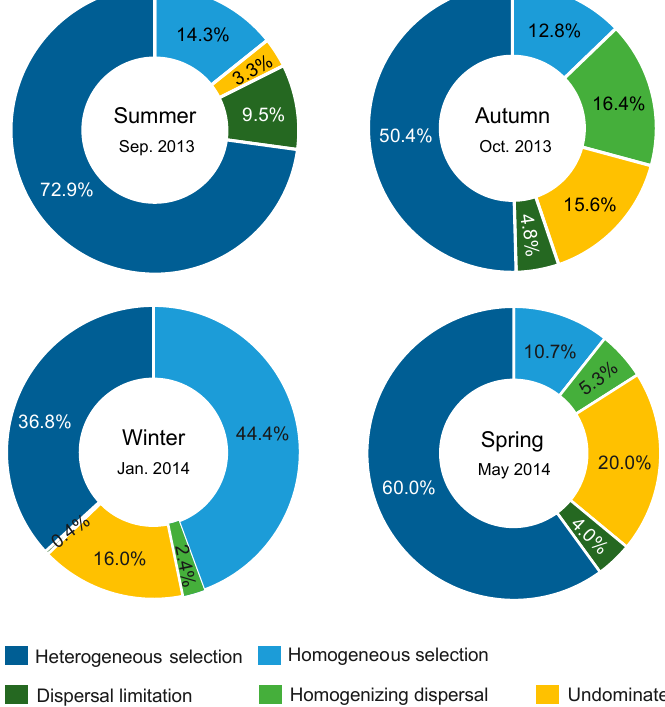
Figure 6. Summary of ecological processes governing bacterial community assembly in each season. The percentage of each process was the relative contribution to all pairwise comparisons between sites.